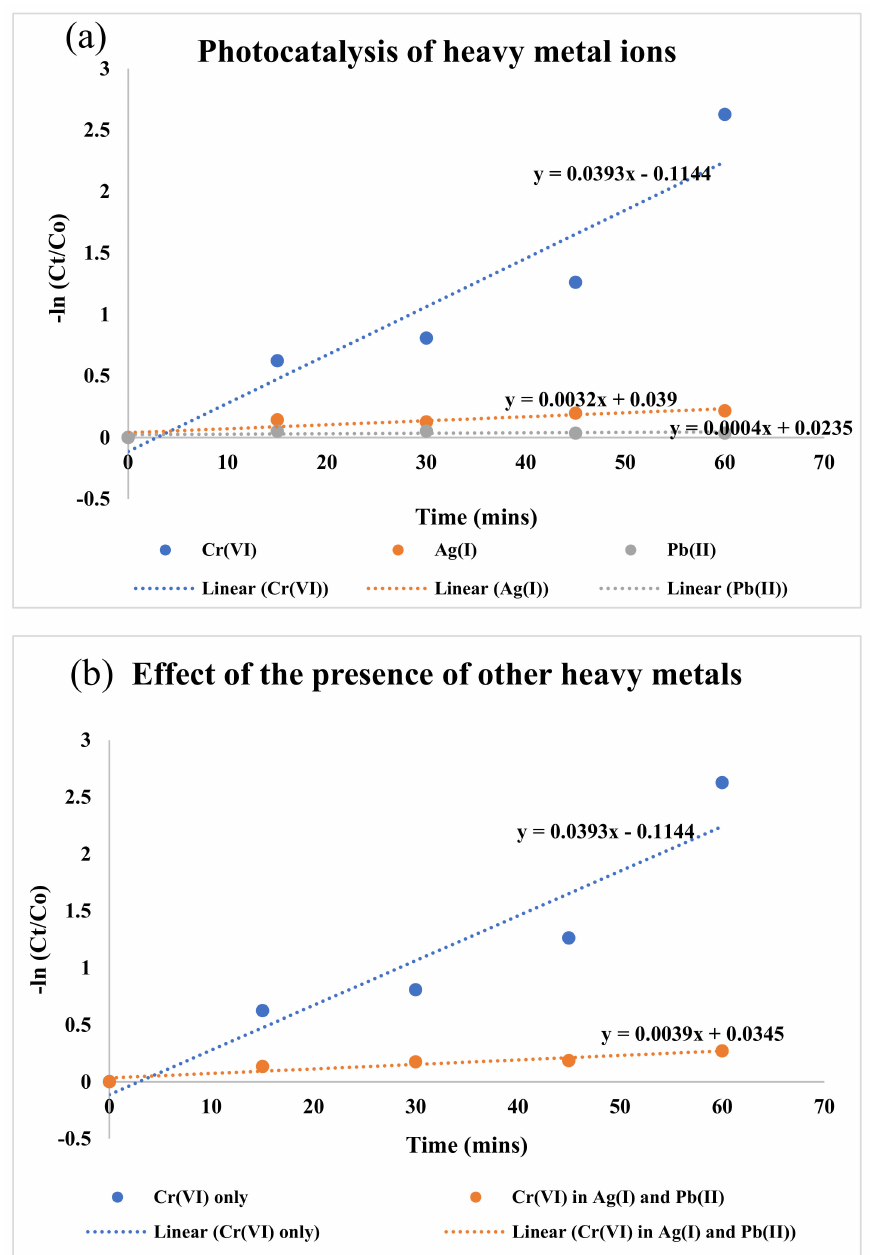
Figure 11. ( a ) Comparative studies of the photocatalytic reduction of Ag(I), Pb(II), and Cr(VI), ( b ) the photocatalytic reduction of Cr(VI) in the presence and absence of Ag(I) and Pb(II). The rate of the photocatalytic reduction of Cr(VI) dropped from 0.0393 to 0.0039 min − 1 (half-life of 17.64 min to 177.73 min) when the mixture of Ag(I) and Pb(II) was introduced into the photocatalytic systems shown in Figure 11b. This clearly shows that the presence of other heavy-metal ions in the system containing Cr(VI) has antagonistic effects on the rate of the photocatalytic reduction of Cr(VI). It has been reported that cations such as Mg(II), Ca(II), K(I), and Na(I) have little effects on the photocatalytic reduction of Cr(VI) due to the high oxidation state and stability of Cr(VI) [61]. On the contrary, the present results show that the presence of heavy-metal ions such as Pb(II) and Ag(I) has a significant